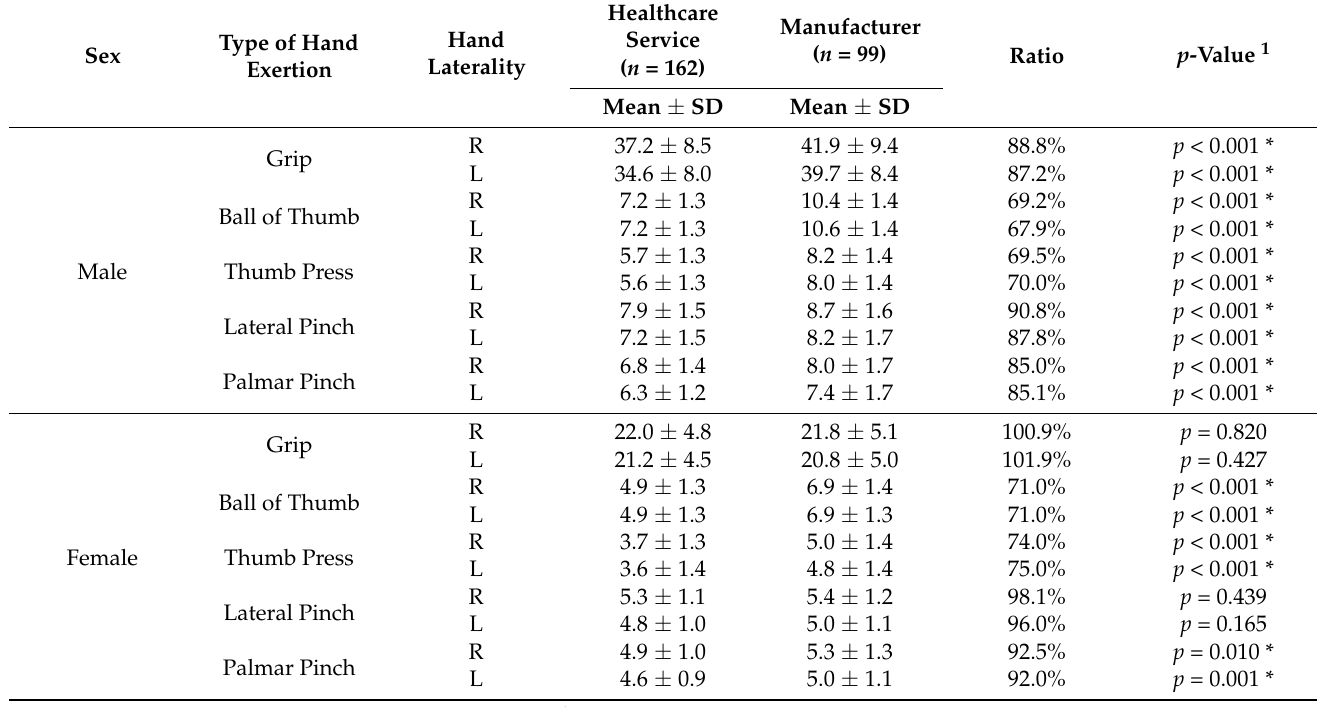
Table 6. Effect of occupation on strength stratified by sex, types of hand movement, and